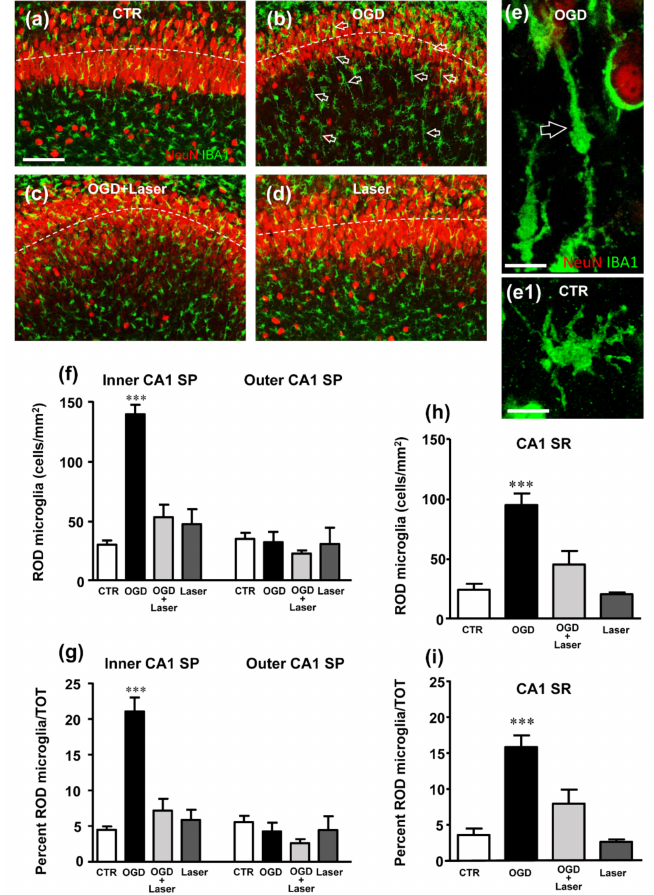
Figure 1. ( a – d ) Representative confocal images of NeuN+ neurons (red) and IBA1+ total microglia (green) in CA1 hippocampus of a CTR ( a ), an OGD ( b ), an OGD+Laser ( c ) and a Laser ( d ) organotypic hippocampal slices captured with a 20 × objective. Images were obtained by stacking 3 consecutive confocal scans (z step 1.2 µ m, total thickness 3.6 µ m). Numerous rod microglia are present in CA1 SP and CA1 SR of OGD slices (open arrows). The dotted lines delineate the inner and outer CA1 SP layers. Scale bar: 50 µ m. ( e ) Confocal 3D-rendering of an IBA1-positive rod microglia (green, open arrow) NeuN-positive neurons (red), captured with a 63 × objective in an OGD organotypic hippocampal slice. The 3D-rendering was obtained stacking 15 consecutive confocal scans (z step 0.3 µ m, total thickness 4.5 µ m). Scale bar: 20 µ m. ( e1 ) Confocal 3D-rendering of an IBA1-positive (green) resting microglia captured with a 63 × objective in a CTR organotypic hippocampal slice. The 3D-rendering is obtained stacking 12 consecutive confocal scans (z step 0.3 µ m, total thickness 3.6 µ m). Scale bar: 20 µ m. ( f ) Quantitative analyses of rod microglia density (cells/mm 2 ) in the inner and outer layers of CA1 SP. Statistical analysis: Inner CA1 SP: *** p < 0.001, OGD vs. all other experimental groups; Outer CA1 SP: no significant differences were found among the 4 experimental groups. ( g ) Quantitative analyses of the percent of rod microglia on total microglia in inner and outer layers of CA1 SP. Statistical analysis: Inner CA1 SP: *** p < 0.001, OGD vs. all experimental groups; Outer CA1 SP: no significant differences were found among the 4 experimental groups; ( h ) Quantitative analyses of rod microglia density (cells/mm 2 ) in CA1 SR. Statistical analysis: *** p < 0.001 OGD vs. all experimental groups. ( i ) Quantitative analyses of the percent of rod microglia on total microglia in CA1 SR. Statistical analysis: *** p < 0.001 OGD vs. all experimental groups. In the bar graphs, each bar represents the mean ± SEM of 5–7 independent slices. All statistical analyses were performed by One-way ANOVA followed by Newman-Keuls post hoc